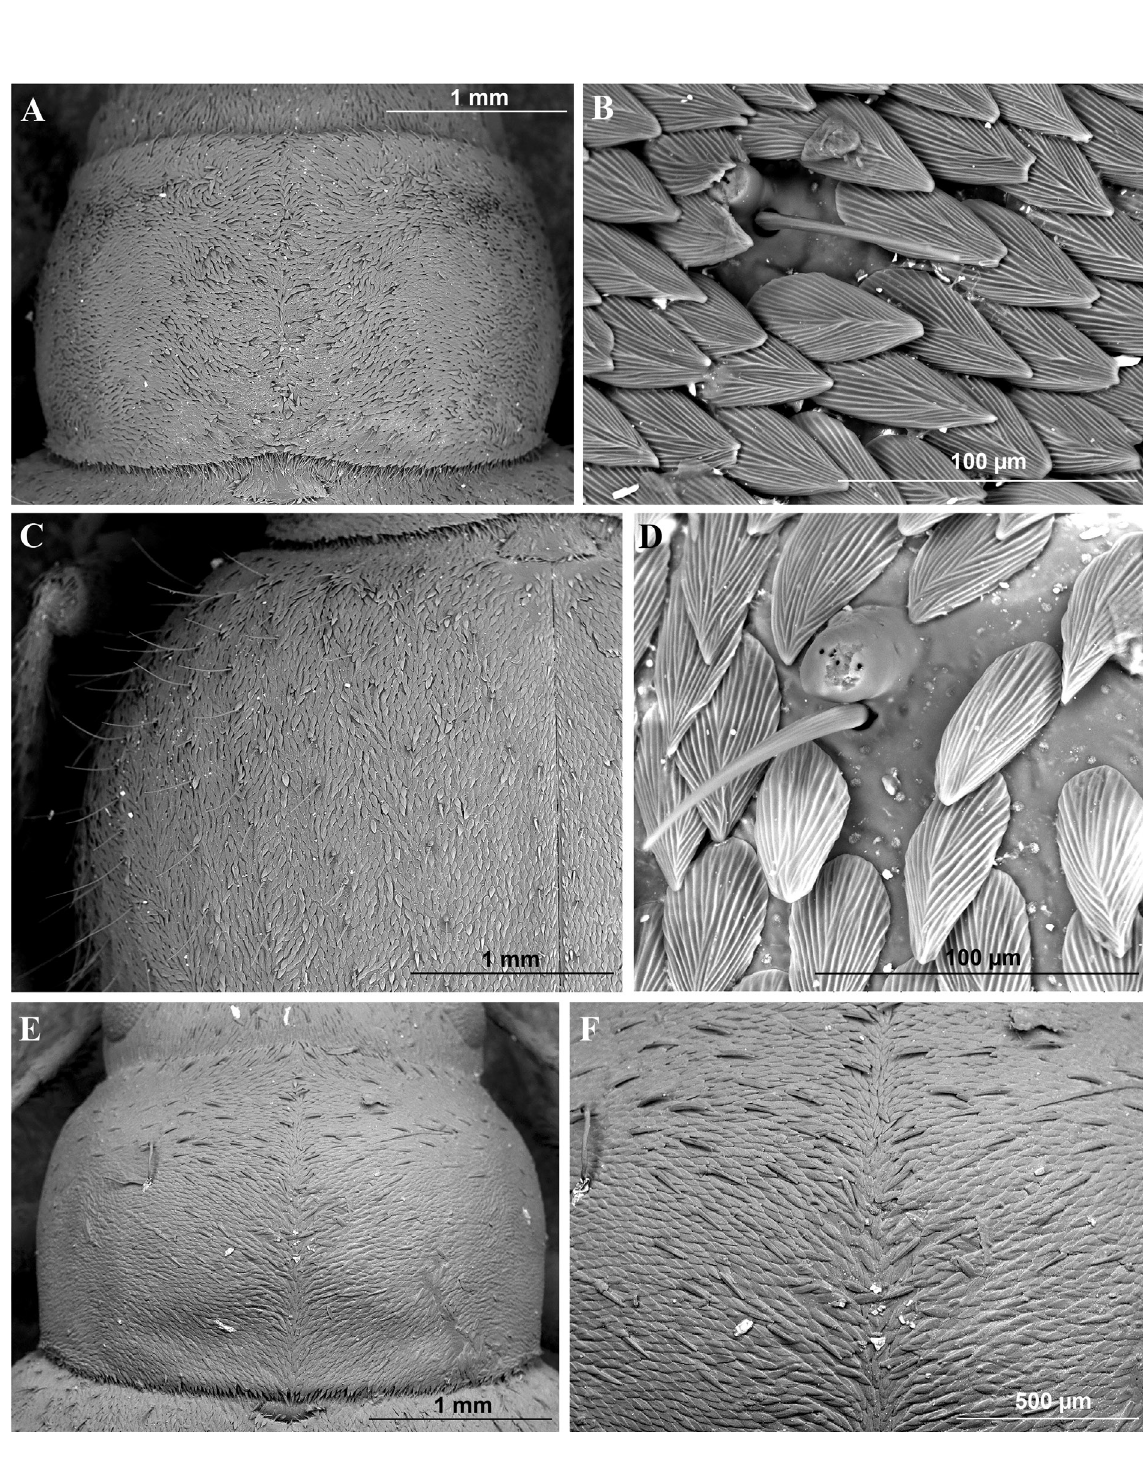
Fig. 8. Apatopsis Semenov, 1891 and Habrobates Semenov, 1903, details of structure. A . A. grombczewskii Semenov, 1891, ♂ (ZIN), pronotum. B . Ditto, scales and seta on pronotum. C . Ditto, elytral scales, setation and granulation. D . Ditto, granule, seta and scales on elytra. E . H. vernalis Semenov, 1903, ♂, paralectotype (ZIN), pronotum. F . Scales and spinulose setation on